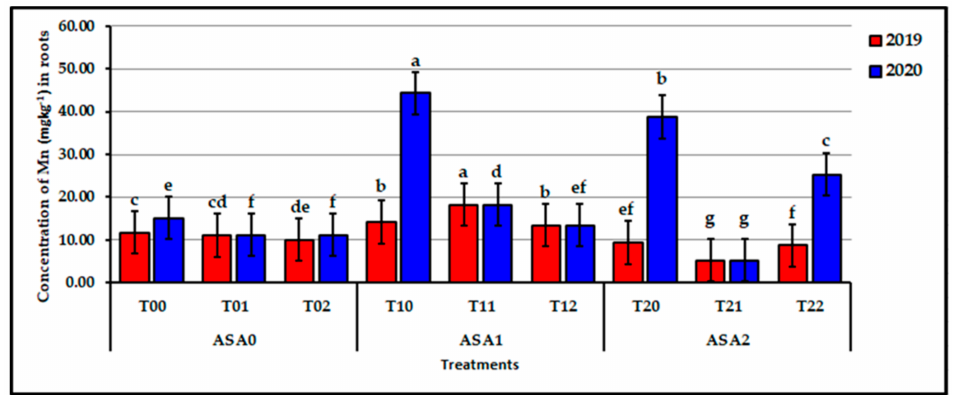
Figure 7. Influence of interaction between zinc oxide nanoparticles and ascorbic acid on root Mn content of stressed sweet potato plants in 2019 and 2020 seasons. Bars with a different letter indicate significant difference between treatments at p ≤